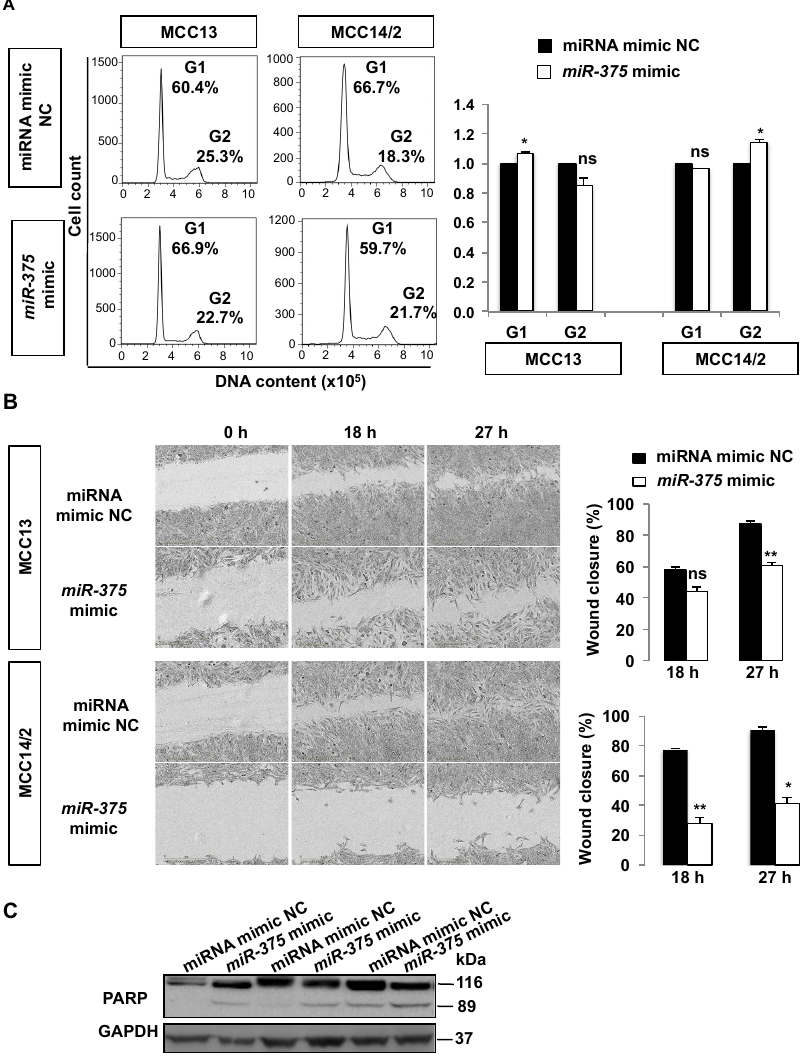
Figure 4. Over-expression of miR-375 reduces cell migration and induces cell cycle arrest and apoptosis in MCPyV− MCC cell lines. MCC13 and MCC14/2 cells were transfected with miR-375 mimic or miRNA mimic NC for 48 h. ( A ) Cell cycle analysis was evaluated in transfected cells by propidium iodide staining and flow cytometric analysis. Left panel: representative histograms illustrating the percentage of cells at G1 and G2 phases in cells with and without over-expression of miR-375 . Right panel: Fractions of cells at G1 and G2 phases were calculated from the histograms of three independent experiments. ( B ) Cell migration was evaluated using wound-healing assay. Left panel: representative images of wound closure at 18 h and 27 h time points. Right panel: the wound closure was calculated based on the difference between wound gap at 18 h or 27 h and 0 h time point and normalized to viable cell number of transfected cells plated in parallel. ( C ) Apoptosis was evaluated after 48 h in MCC cells transfected with miR-375 mimic or NC using Western blot analysis of anti-PARP (BD Pharmingen), which recognizes the full-length (116 kDa) and apoptosis-associated cleaved (89 kDa) forms. GAPDH was used as a loading control. * p < 0.05 and ** p < 0.01 by paired Student’s t -test. ns = not significant.